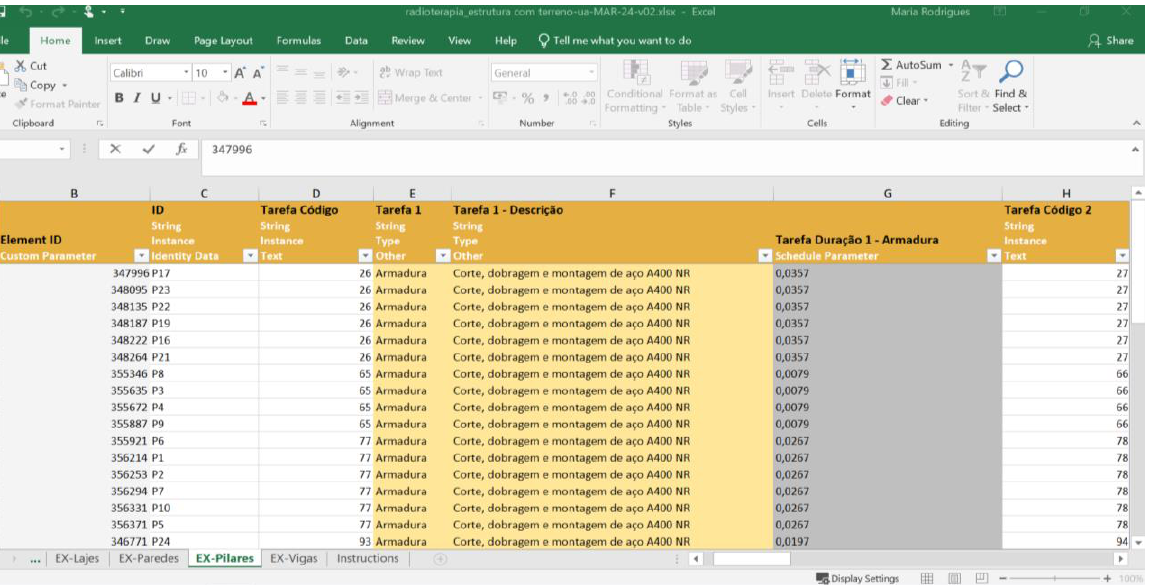
Figure 7. Spreadsheets data exchange with Revit model.